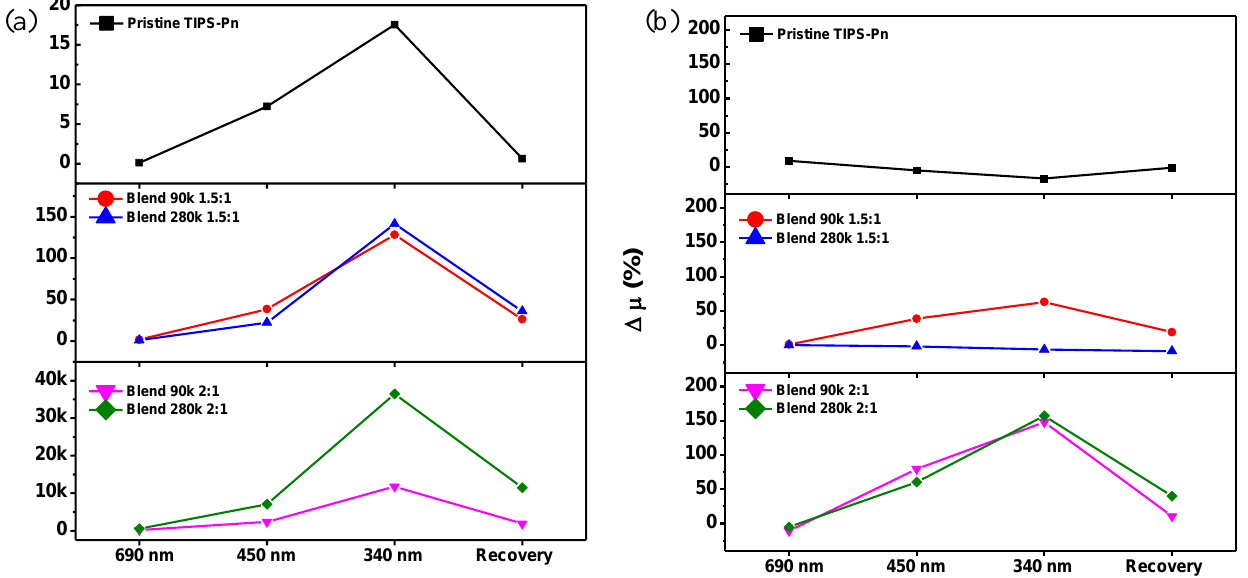
Figure 5. ( a ) Photosensitivity and ( b ) field-effect mobility of the fabricated TFTs under irradiation light of 690, 450, and 340 nm and recovery to the initial dark state.